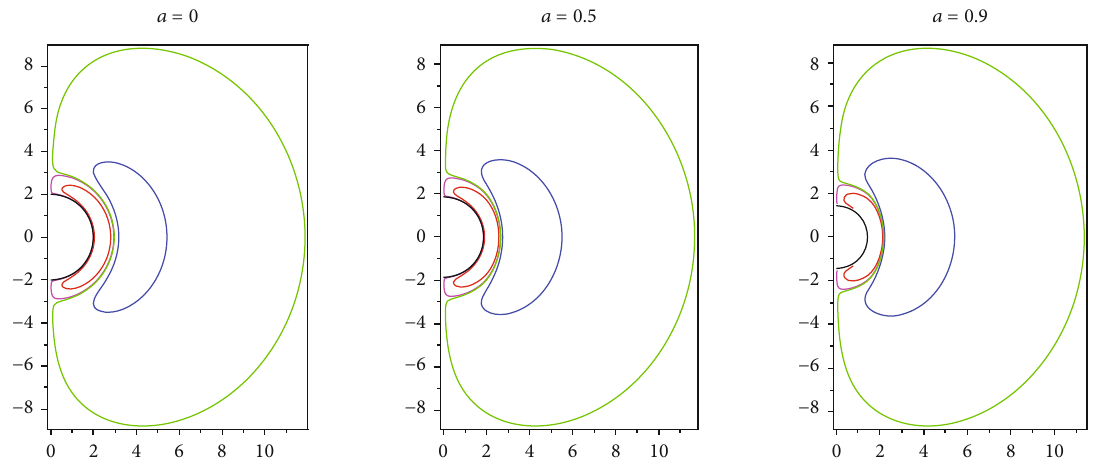
Figure 4: Contours of pro fi les of revolution around the vertical axis (rotation axis) depicting constant current density lines (36) corresponding to Example 2 for three di ff erent values of the Kerr parameter a . The red curve corresponds to J = 0 : 002 , blue to J = − 0 : 002 , magenta to J = 0 : 0001 , and green to J = − 0 : 0001 . The black circle is the black hole ’ s